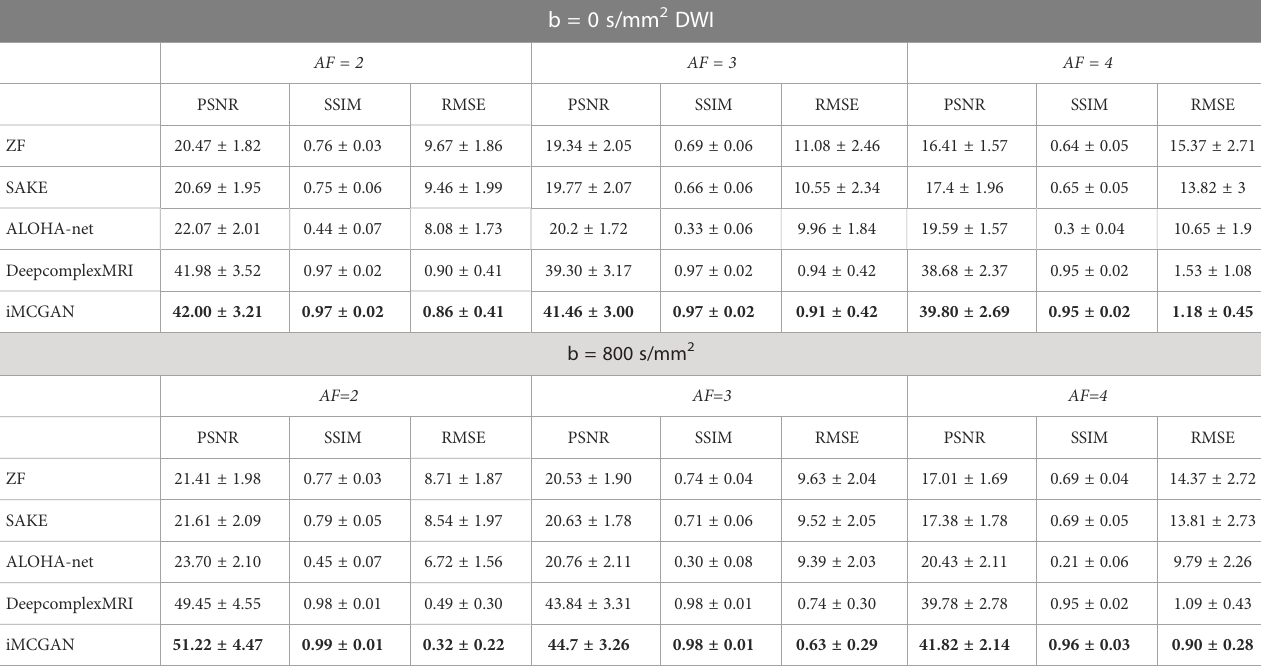
TABLE 2 The PSNR, SSIM and RMSE of different reconstruction methods with the AF of 2, 3, and